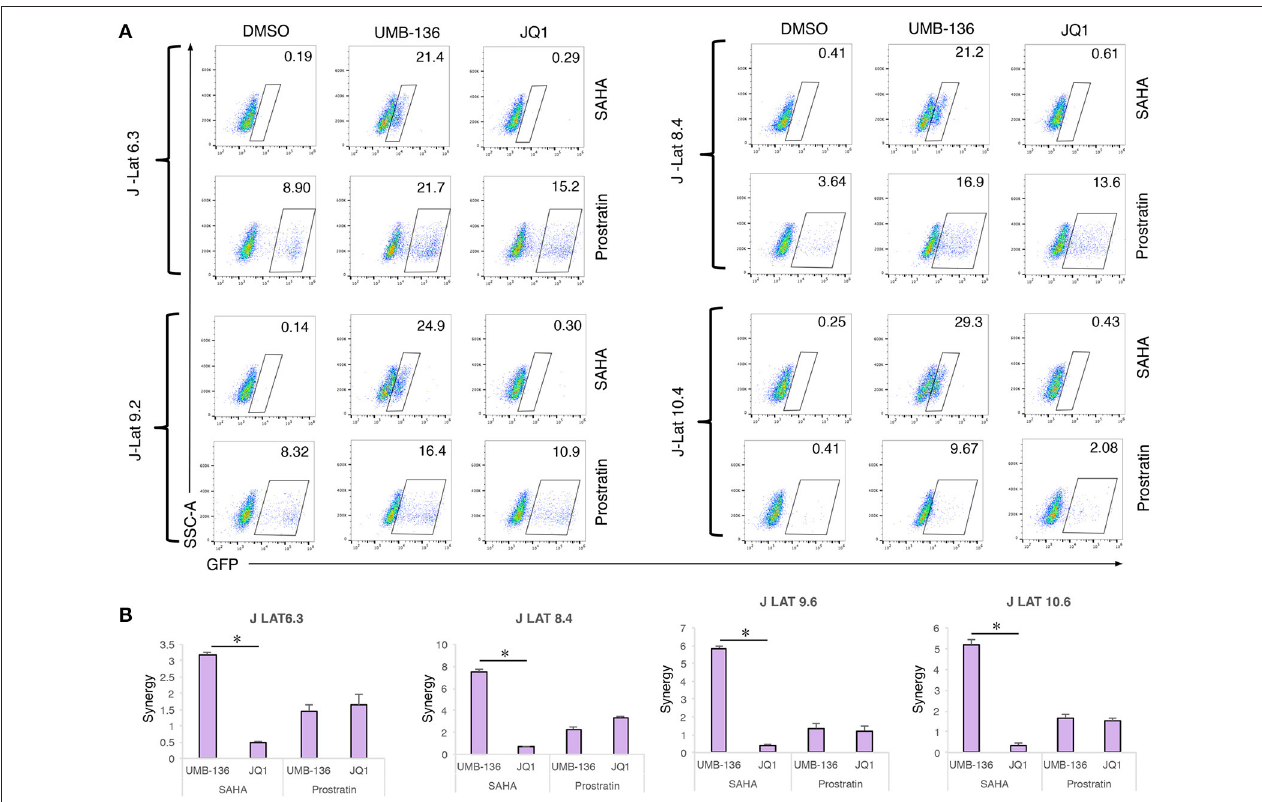
FIGURE 4 | UMB-136 synergizes with other LRAs to reverse HIV-1 latency in J-Lat cell lines. (A) Multiple J-Lat cell clones (6.3, 8.4, 9.2, and 10.4) were treated with UMB-136 (2.5 µ M) or JQ1 (1 µ M) in combination with an HDACi (SAHA, 0.5 µ M) or a PKC agonist (prostratin, 1 µ M). GFP-positive cells were acquired and analyzed by flow cytometry. Percentage of GFP-positive cells was measured. One representative of three independent experiments was shown. (B) The synergistic analysis of LRA combinations. The synergy of LRA combinations in Figure 3A was evaluated using the Bliss independence model (Bliss, 1939). Data are represented as the mean ± SD of biological duplicates. * p < 0.05, t